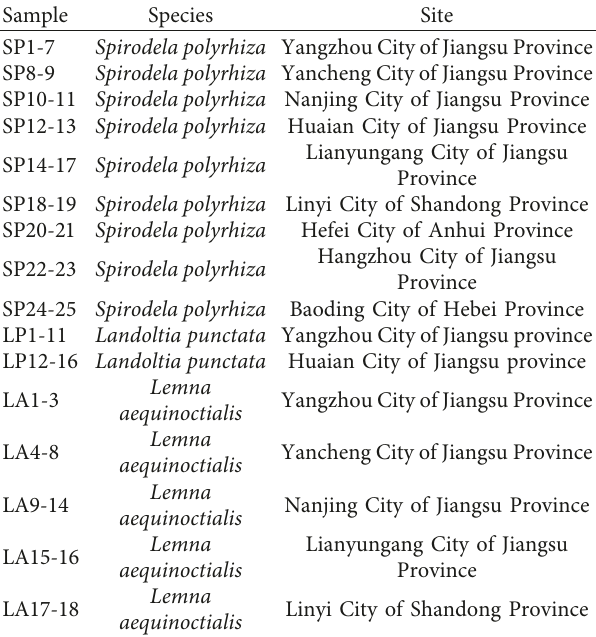
Table 1: Information of duckweeds from different regions.